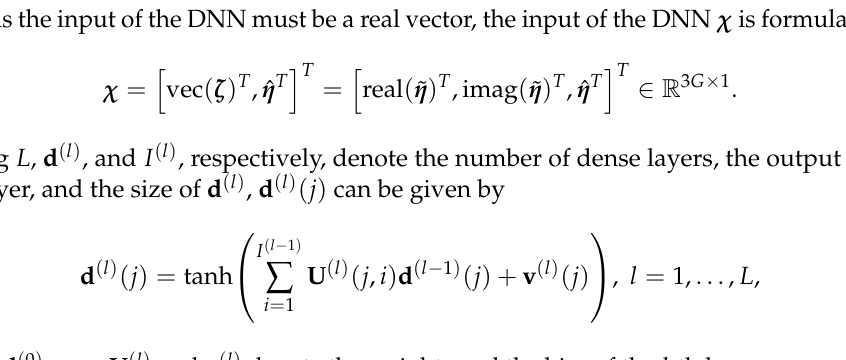
Figure 2. Determination of final estimated DoAs by using the output of the first-stage network ˆ η and the output of the second-stage network ˆ ψ